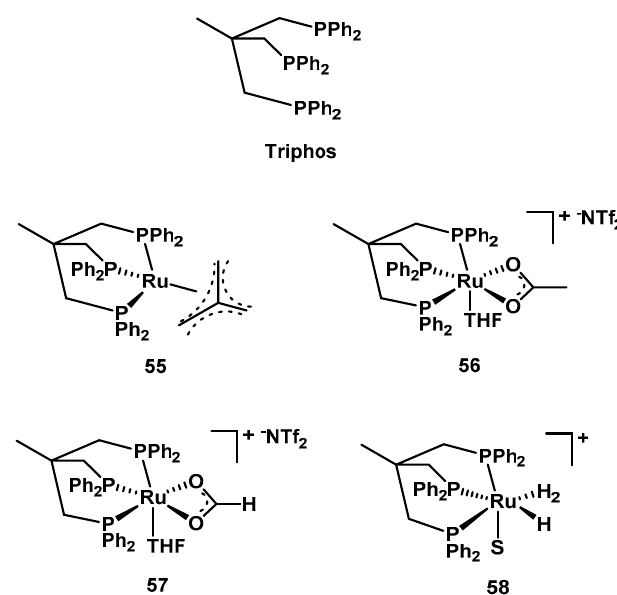
Figure 3. Ruthenium catalysts 55 and 56 based on the triphos ligand, and active formate species 57 and 58 (S = solvent or substrate)